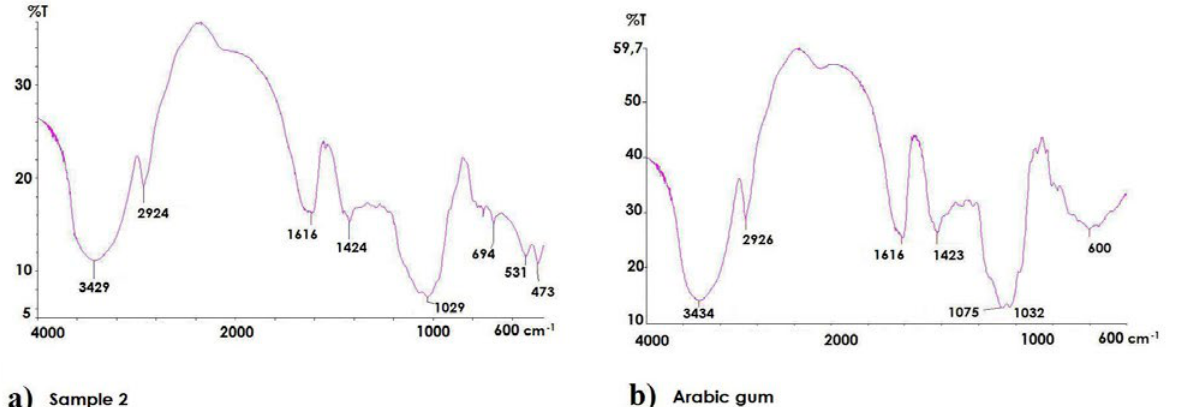
Figura 3. Product A, sample 2. – a) FT-IR spectrum; b) FT-IR spectrum of arabic